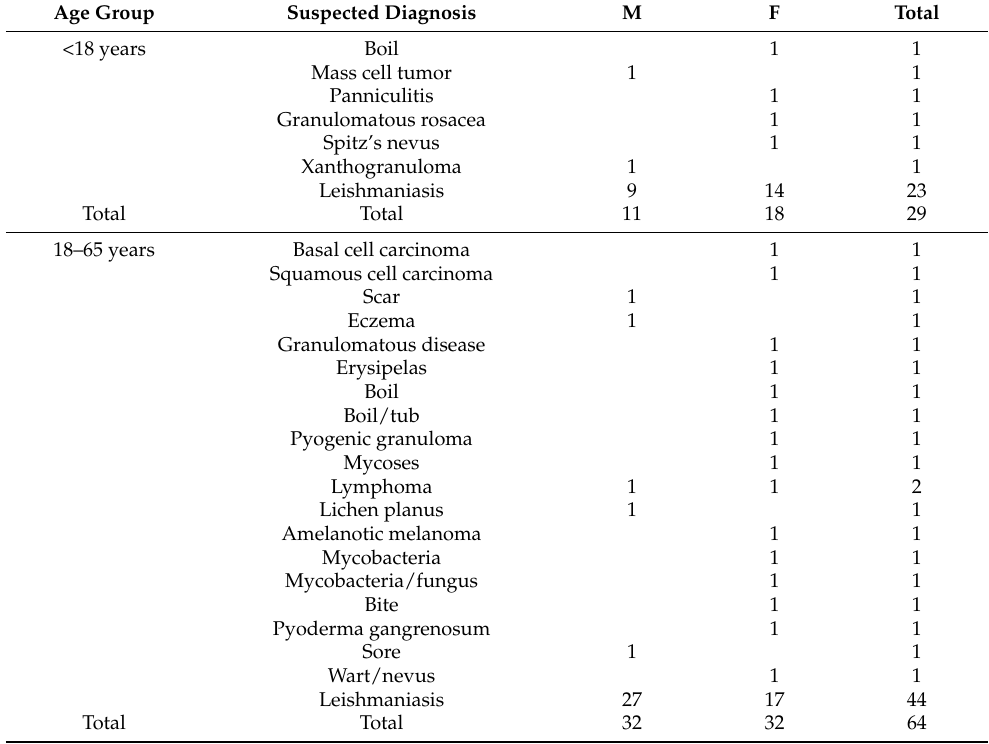
Table 2. Suspected clinical diagnosis of cases by age